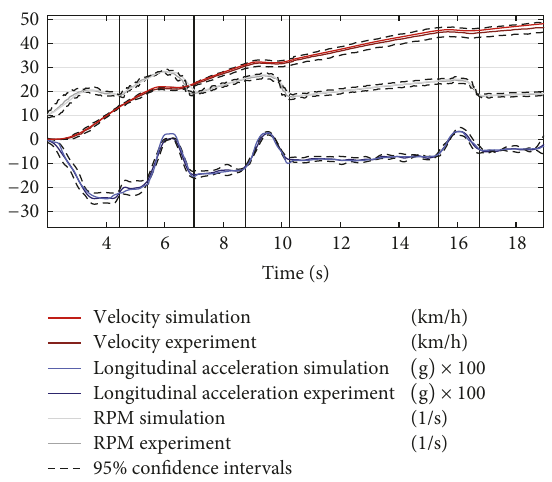
Figure 17: Validation Maneuver Long-III: experimental data zones.